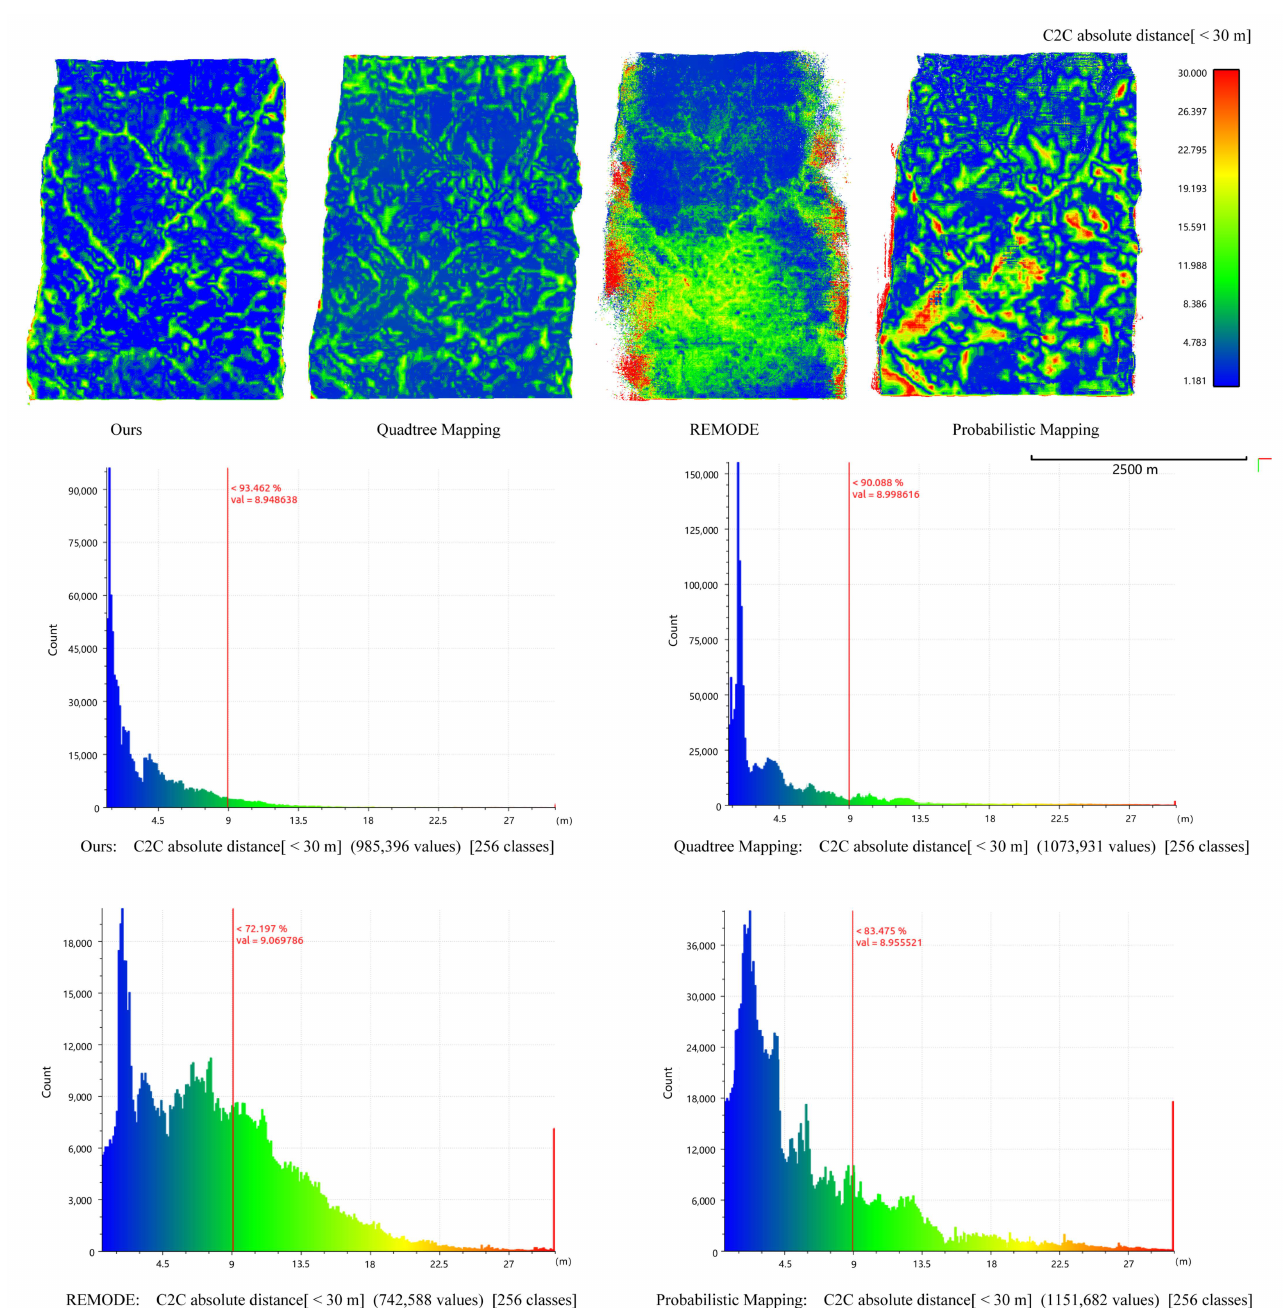
Figure 13. Comparison of absolute distance error (m) in sequences of synthesized 1000 m height